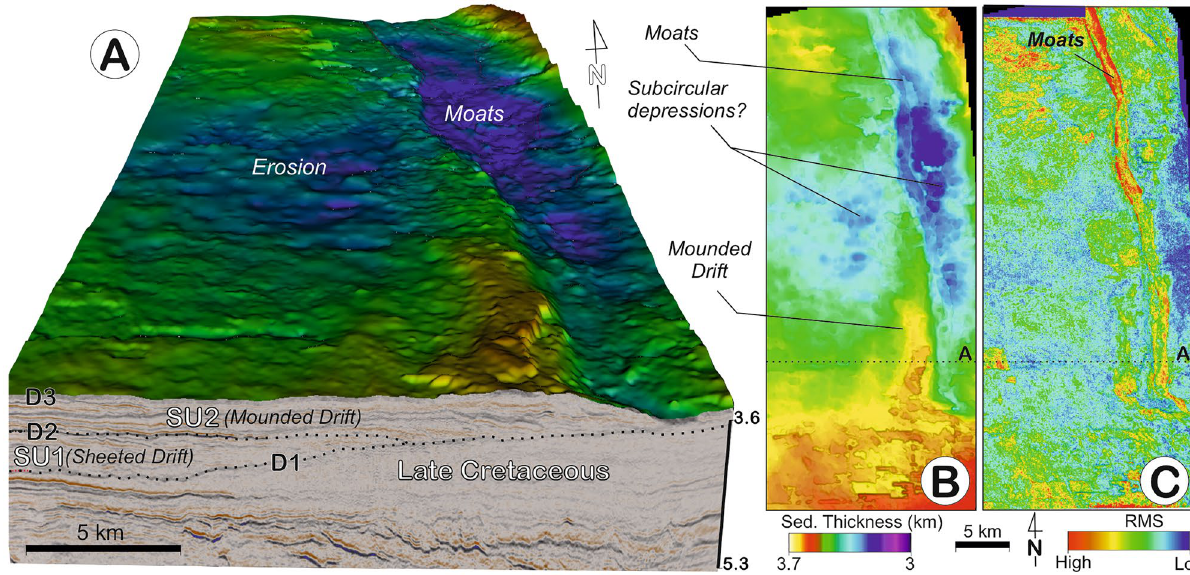
Figure 3. ( A ) 3D block showing regional relief for the top of the mounded drift (D3) and its adjacent moat. ( B ) Thickness map for SU2, and ( C ) surface map for the top of SU2